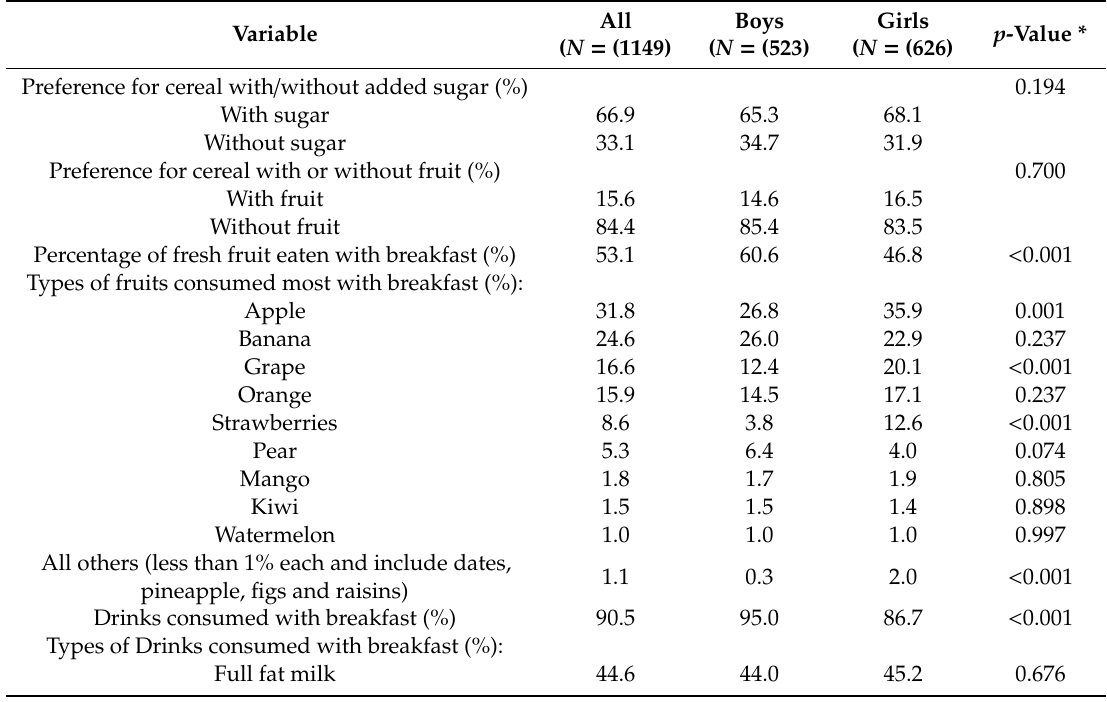
Table 5. Some breakfast intake preferences at home by Saudi children relative to gender (more than one choice was